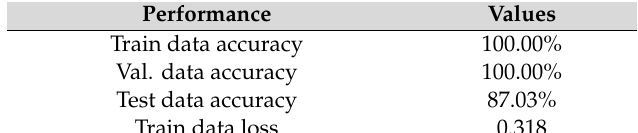
Figure 16. The training loss history.